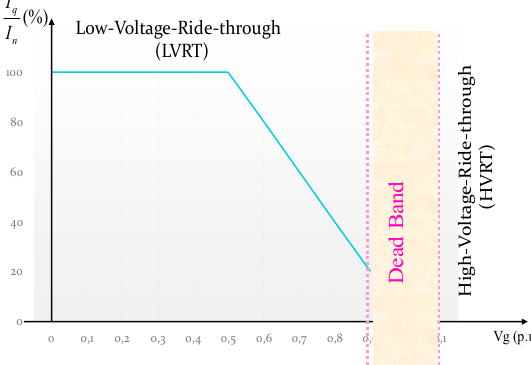
Figure 6. Low-voltage ride-through (LVRT) requirements.